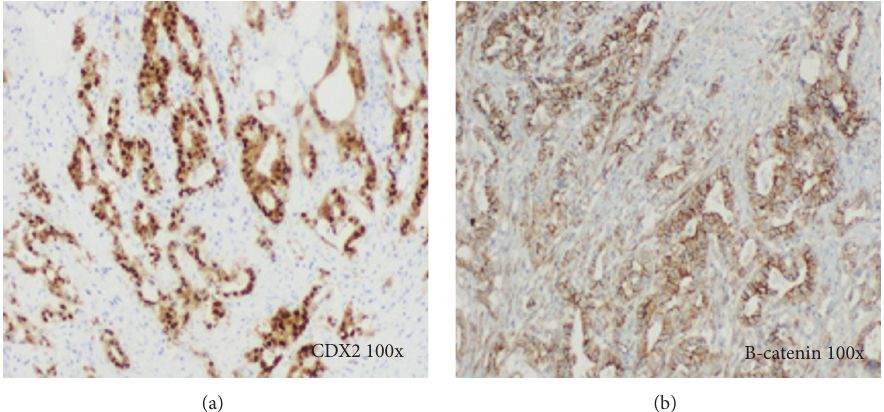
Figure 5: Immunostains: (a) CDX2 positive staining in the tumor; (b) 𝛽 -catenin negative nuclear staining in the majority of the tumor.